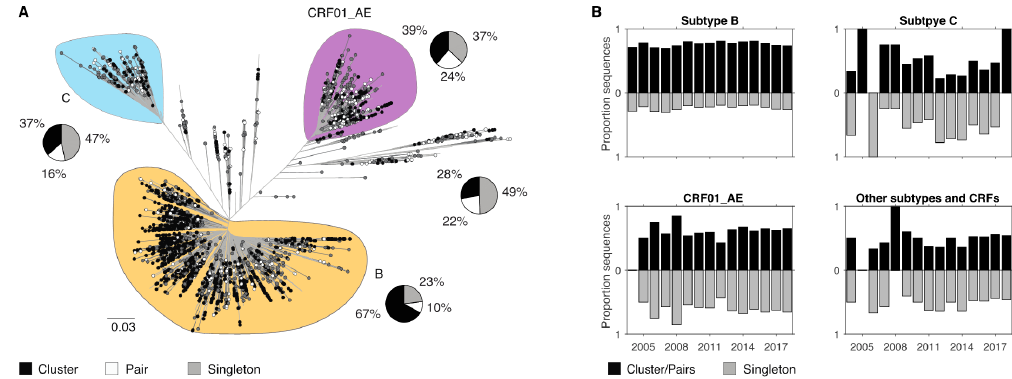
Figure 3. HIV-1 clusters in NSW for different subtypes. ( A ) Unrooted maximum likelihood tree from NSW and global reverse transcriptase sequences. Branch length indicates nucleotide substitutions per site. Circle at tips indicate sequences from NSW, while sequences without circles are global sequences. Clades representing subtype B, C, and CRF01_AE are colored. Tip circles are colored according to being part of a cluster (black), sequence pair (white), or a singleton (gray). The proportion of sequences associated with each cluster type or singleton is shown as a pie chart for the four subtype groups analysed. ( B ) Proportion of sequences from infections associated with cluster and pairs or being singletons are shown for the four subtype categories across time.